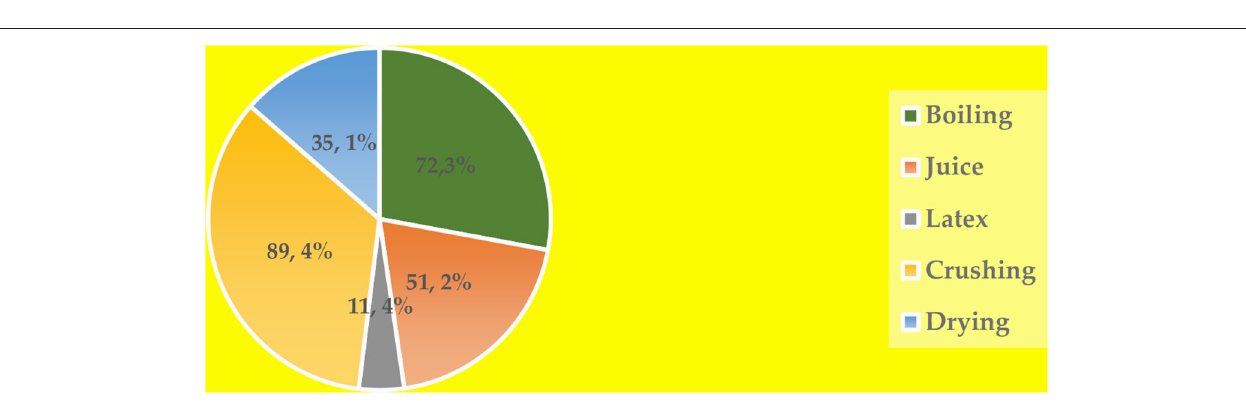
FIGURE 3 | EVM preparation methods used in Kunene and Omusati regions, Namibia (n =